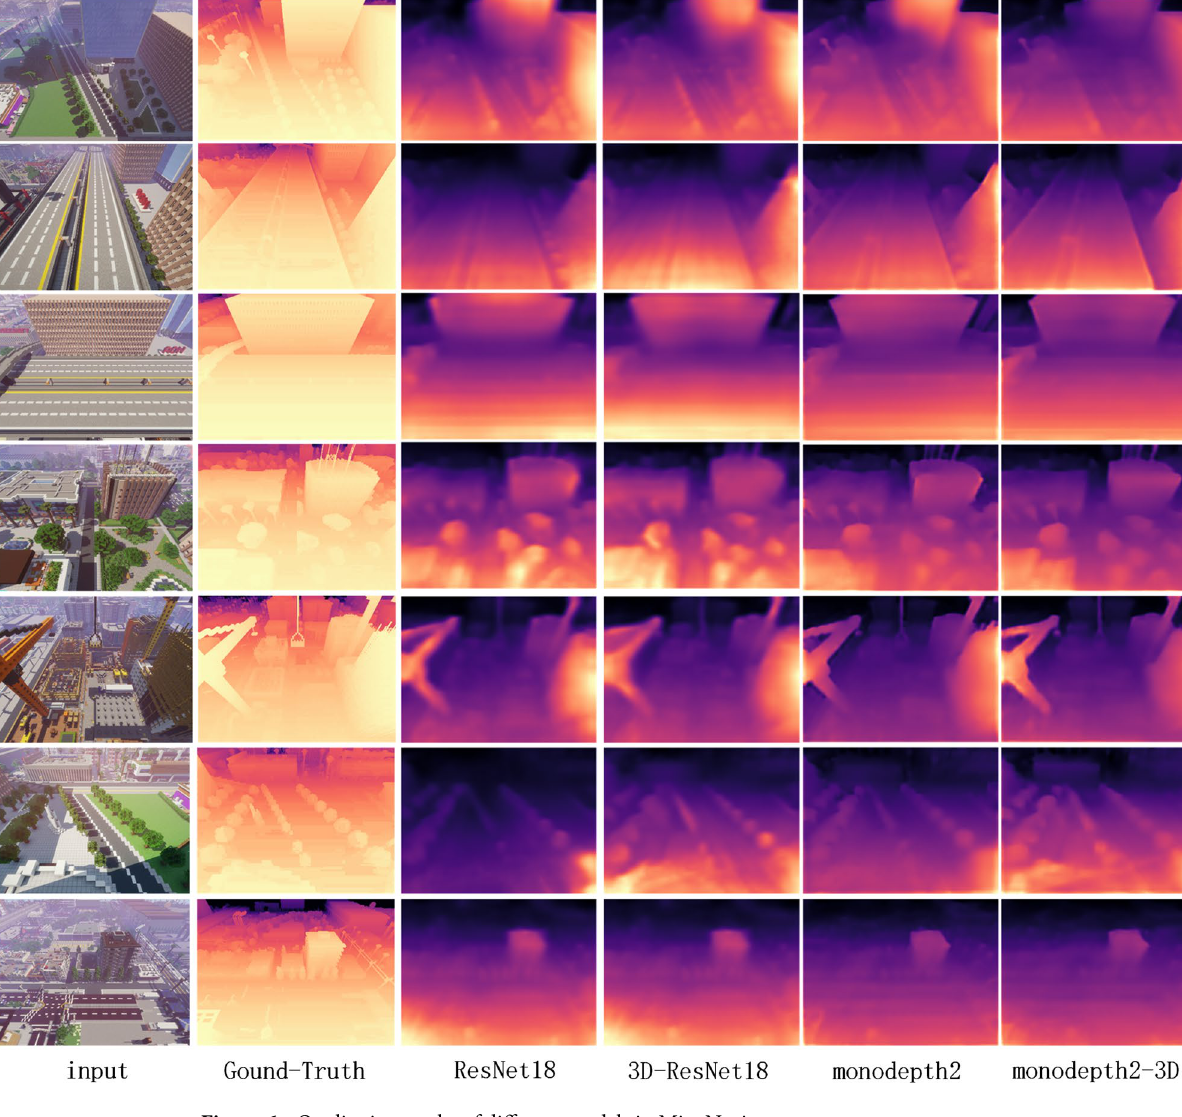
Figure 6. Qualitative results of different models in MineNavi.